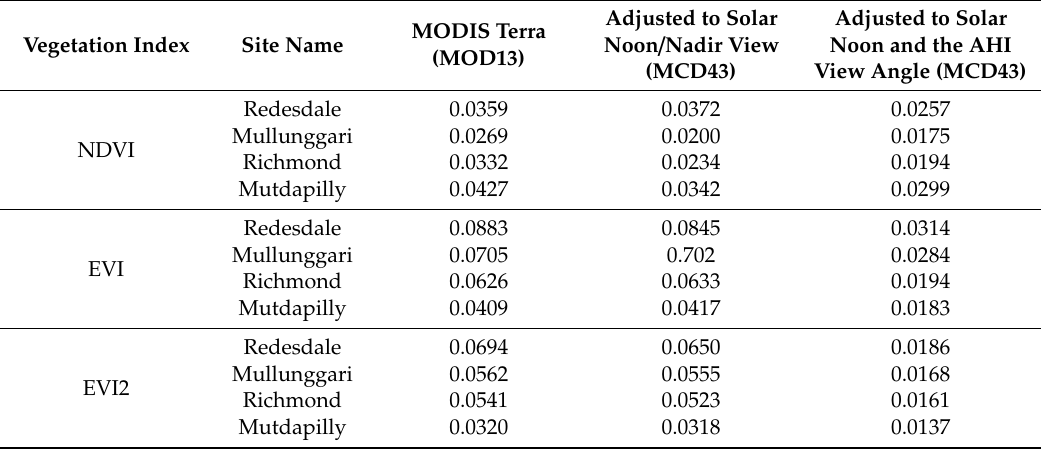
Figure 11. Comparison of smoothed, daily composite AHI NDVI ( left ), EVI ( center ), and EVI2 ( right ) with the standard Terra MODIS VIs, the MODIS BRDF-adjusted to solar noon, and the MODIS BRDF-adjusted to solar noon and the AHI view angle, over the 2016 and 2017 growing seasons at the four grassland sites. Table 4. The mean absolute di ff erence (MAD) of NDVI, EVI, and EVI2 values between Himawari-8 AHI and the various observation geometry adjusted MODIS